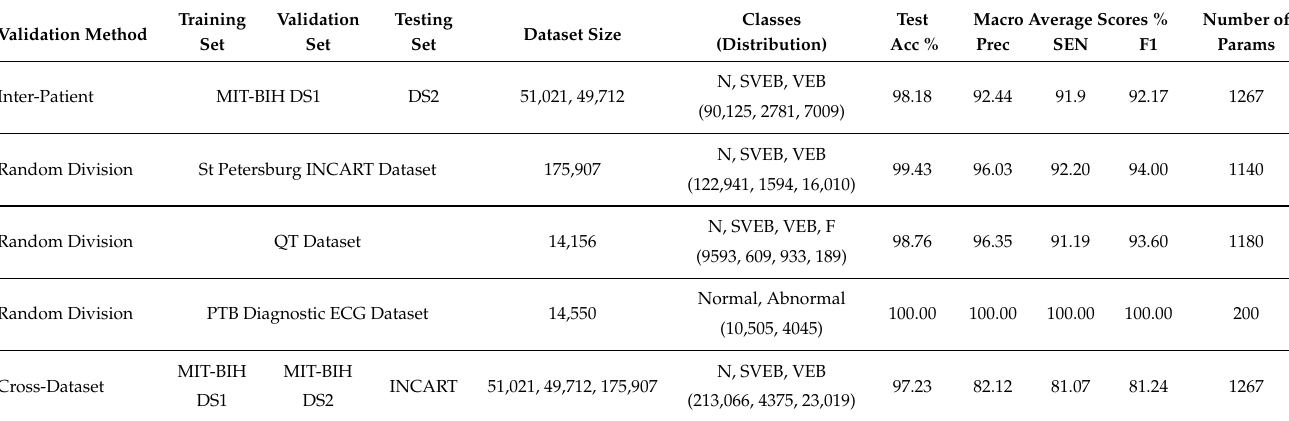
Table 6. Model generalization validation results on the INCART, QT, and PTB diagnostic